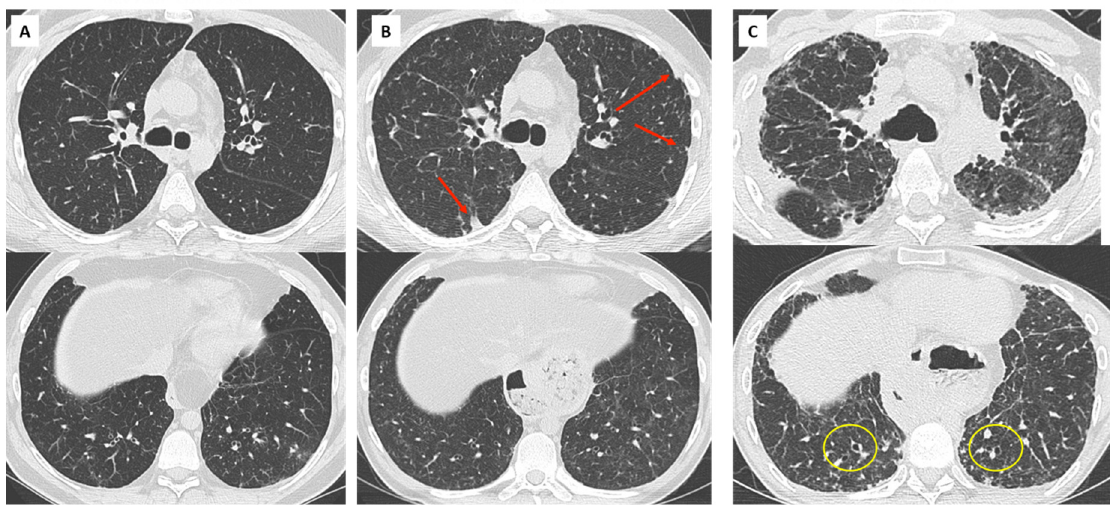
Figure 8. Mixed CLAD in a 30-year-old patient. ( A ) Diagnosis of CLAD in 2007 with initial obstructive phenotype. CT shows mild bronchial wall thickening; ( B ) progressive decline in TLC, suggesting an evolution towards a mixed CLAD (oct 2009). Note the apparition of subpleural opacities in the upper lobes (red arrows) and mild and diffuse ground glass opacities; ( C ) rapid functional and radiological deterioration, with upper predominant fibrosis and subpleural consolidation suggesting PPFE, mild cylindrical bronchiectasis in the lung bases (yellow circles).